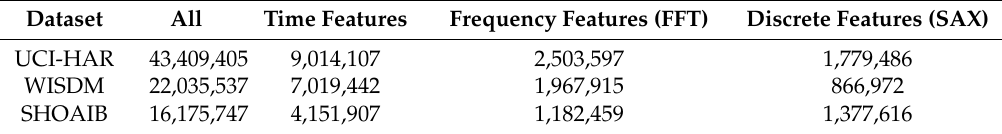
Table 7. Memory consumption in data bytes before and after the feature extraction